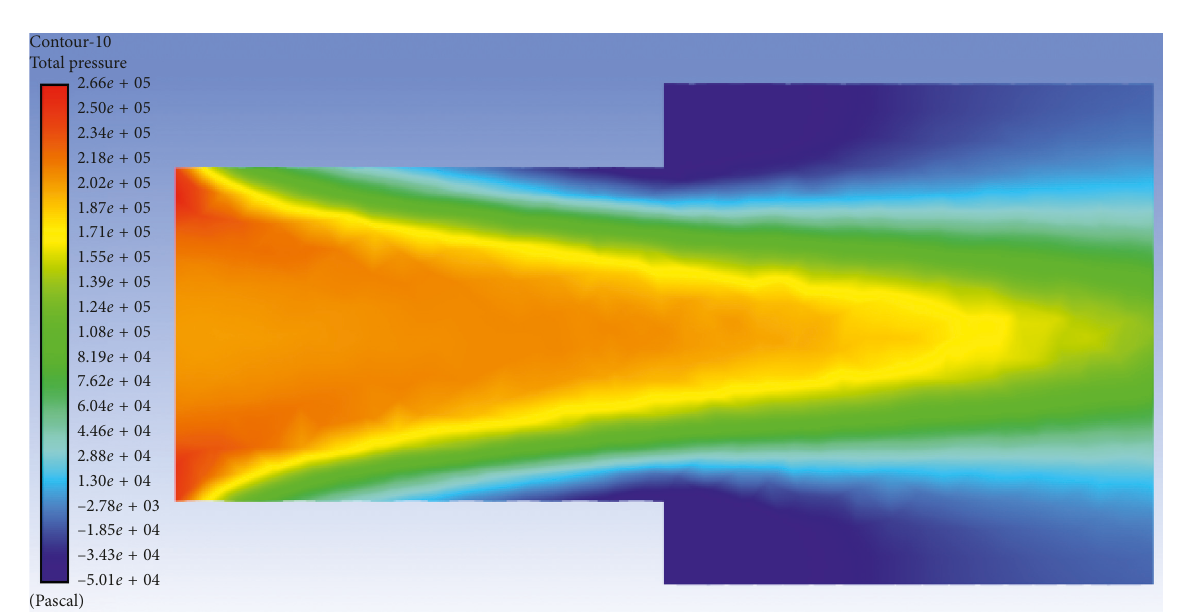
Figure 21: Pressure nephogram without chamfer (sudden spread ratio is